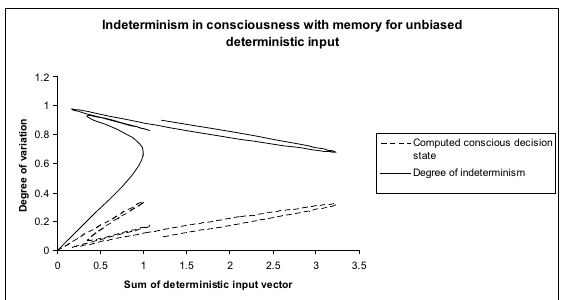
Fig. 17. Variation of state of consciousness in system with memory (fair C1).